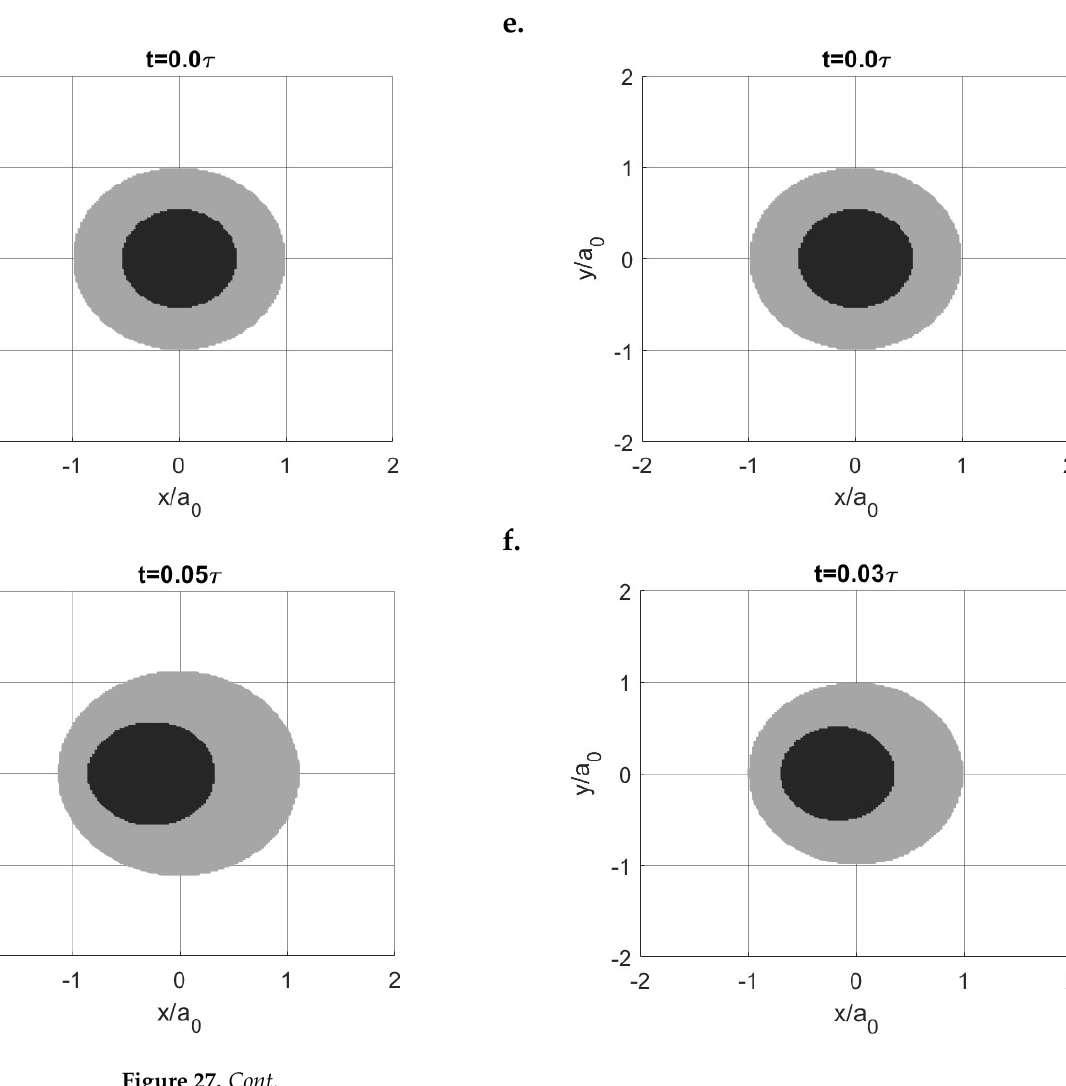
Figure 26. Fully coupled solution regarding the variations in the stick ratio with time under different inputs (creep or stress relaxation) in the normal direction.